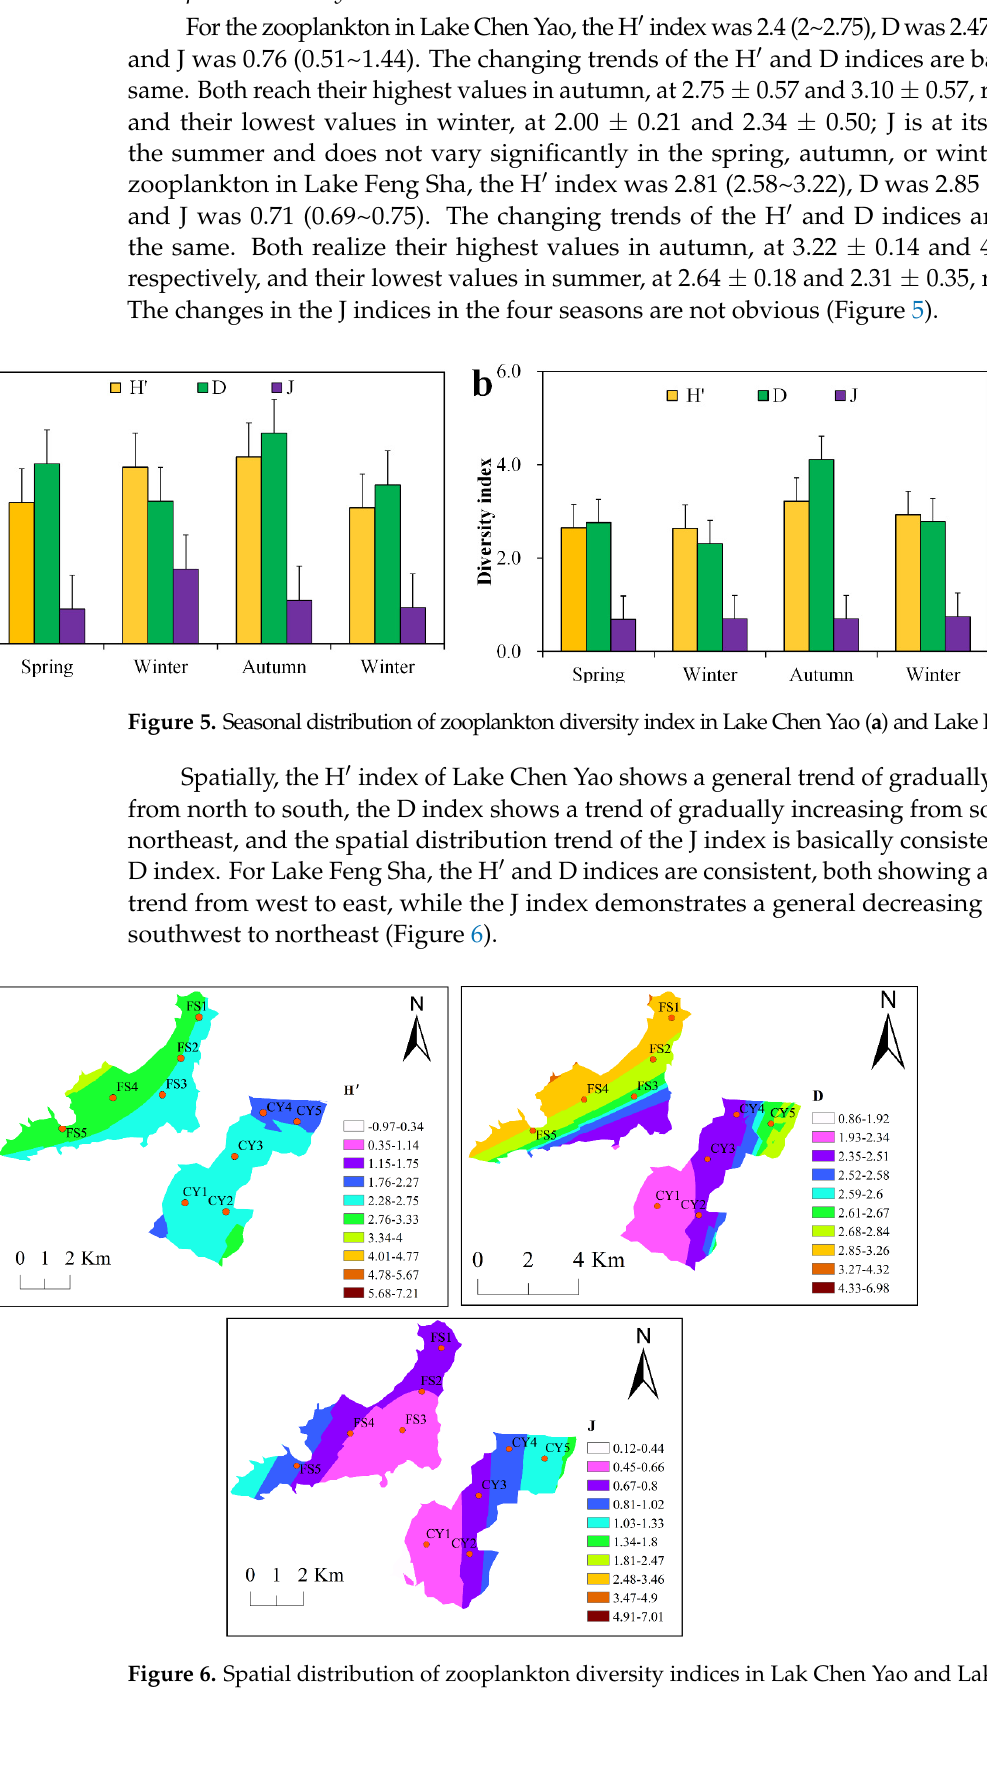
Figure 4. Percentage species composition of the zooplankton community in Lake Chen Yao ( a ) and Lake Feng Sha ( b ).